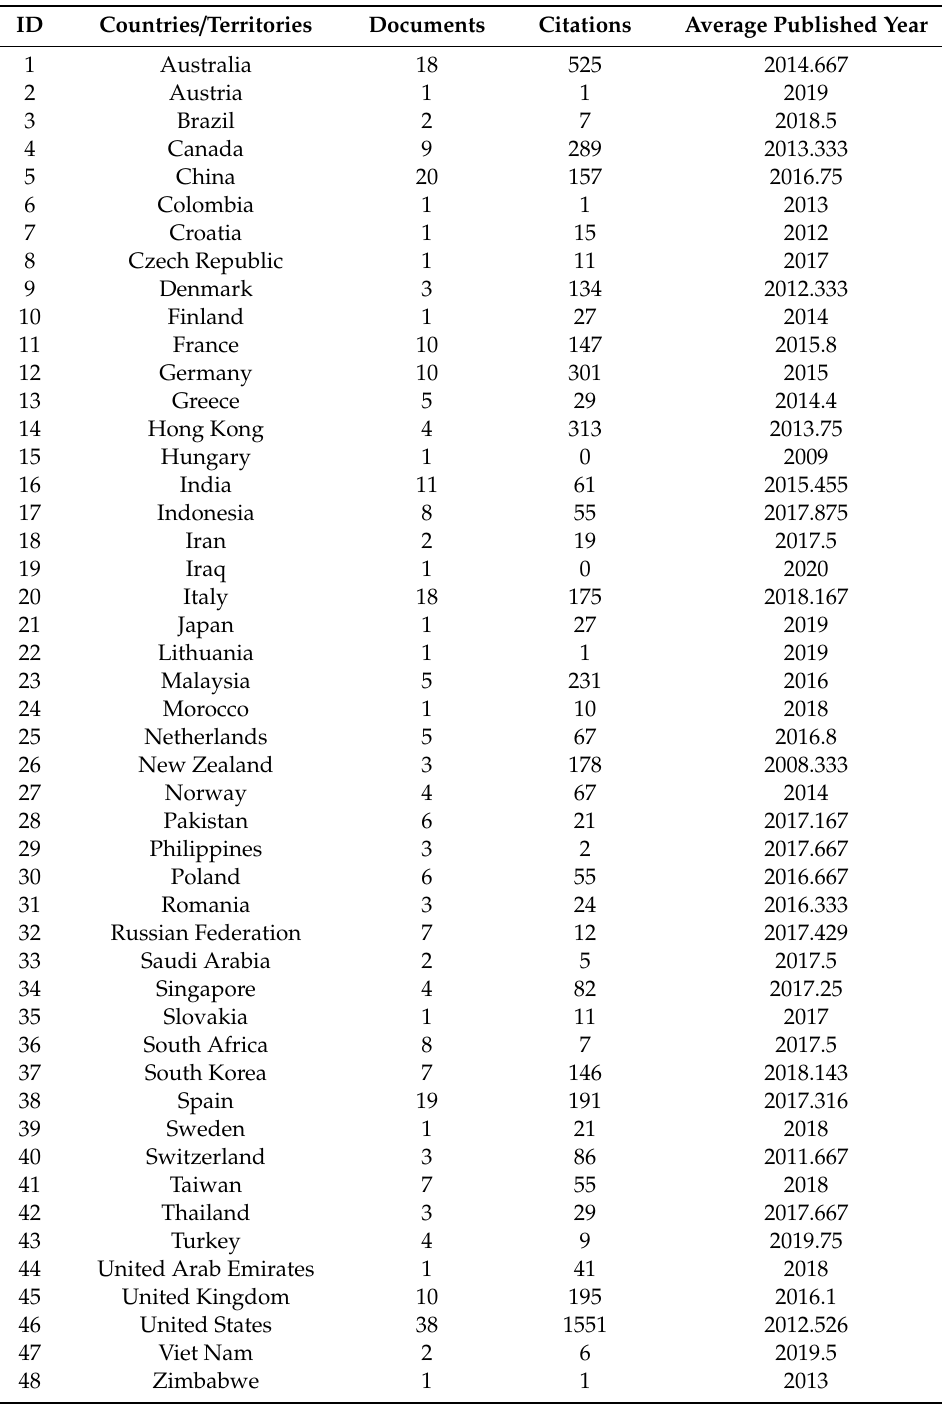
Table 1. Bibliographic coupling of countries /